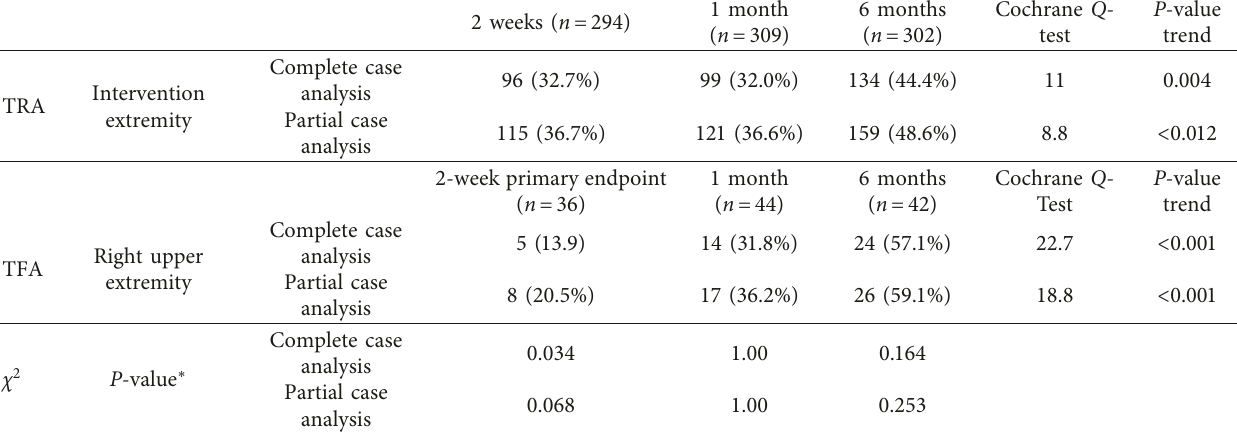
Table 2: Primary endpoint and long-term upper extremity dysfunction during follow-up in different